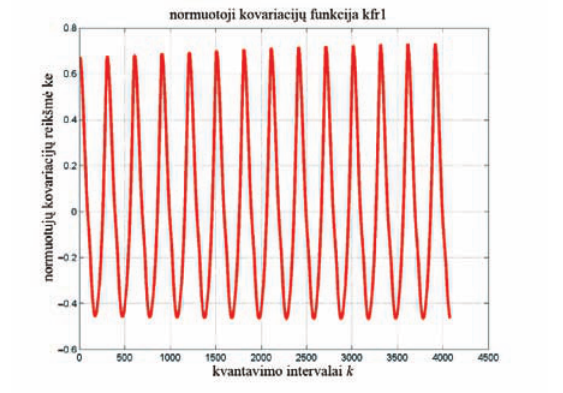
Fig. 8. Change of the vector covariance coefficient of the tenzor of the digital image for the lens of the eye with contact lens